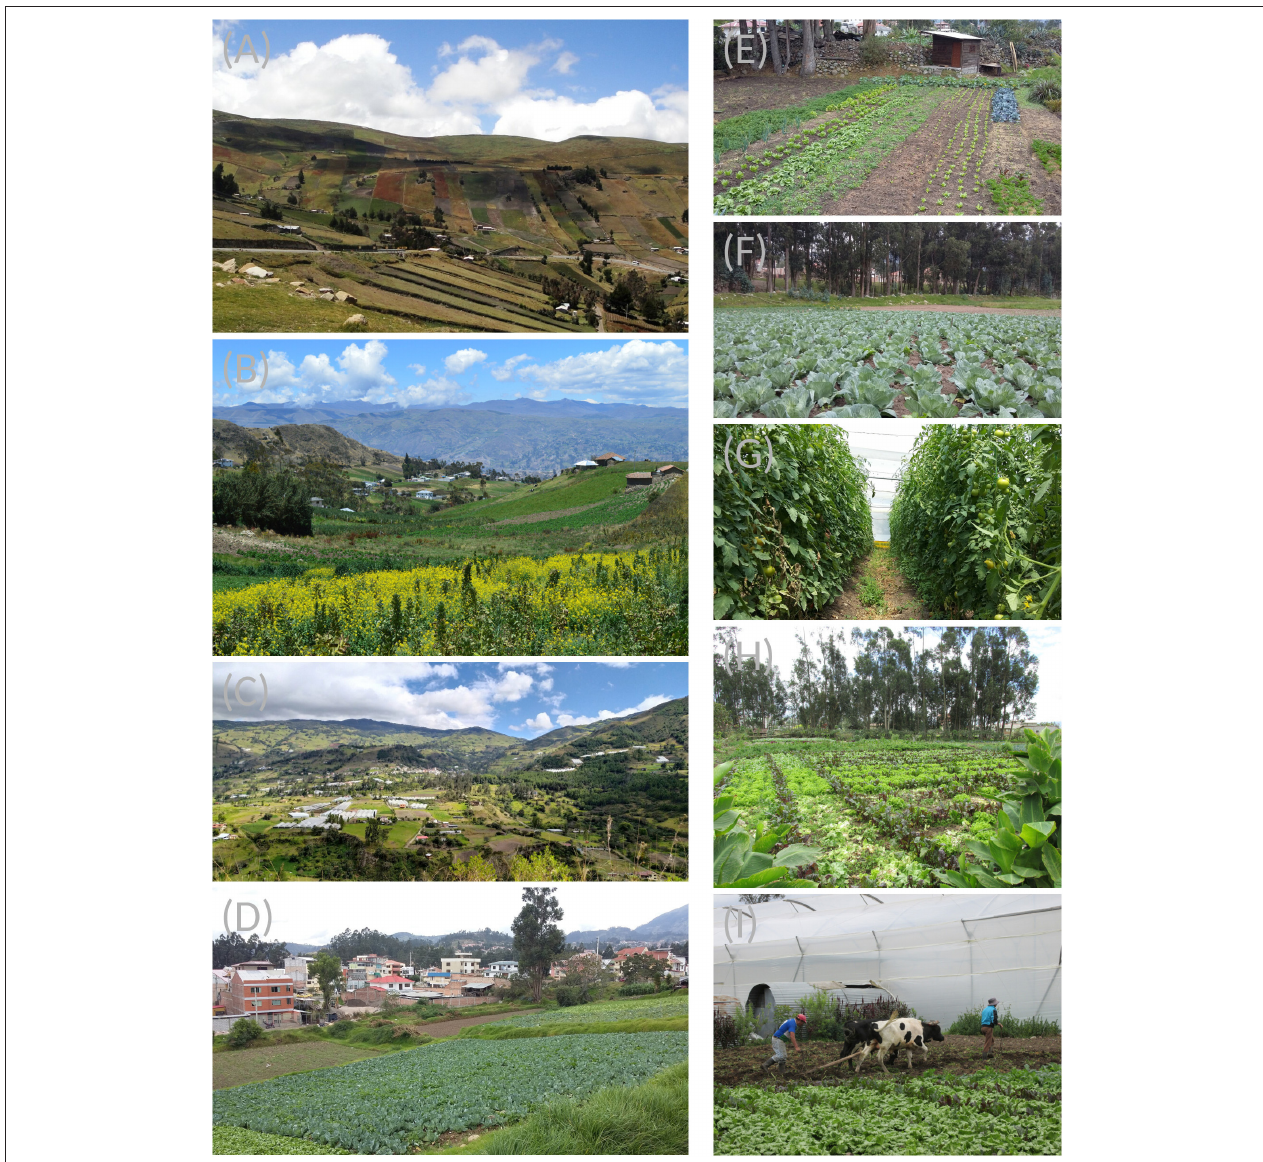
FIGURE 1 | Diversity in smallholder farms in the Ecuadorian Andes. Typical landscapes of regions were smallhoder farming is practiced: ( A,B) Farms at high elevations (potato, grains, pulses, pastures, other tuber/root crops), panel (B) shows a typical rotation consisting in pasture (background), potato, fallow and fava beans (foreground), (C) Farms in lower mountain slopes and valleys (vegetables, fruits, greenhouse horticulture), (D) Urban and periurban farms (vegetables). Panels (E–I) show representative subsistence (E) and transitional (F) systems, greenhouse (G) and diversified agroecological (H) systems and the combination of traditional (oxen plow) and modern technologies (greenhouses) in some of these farms (I)